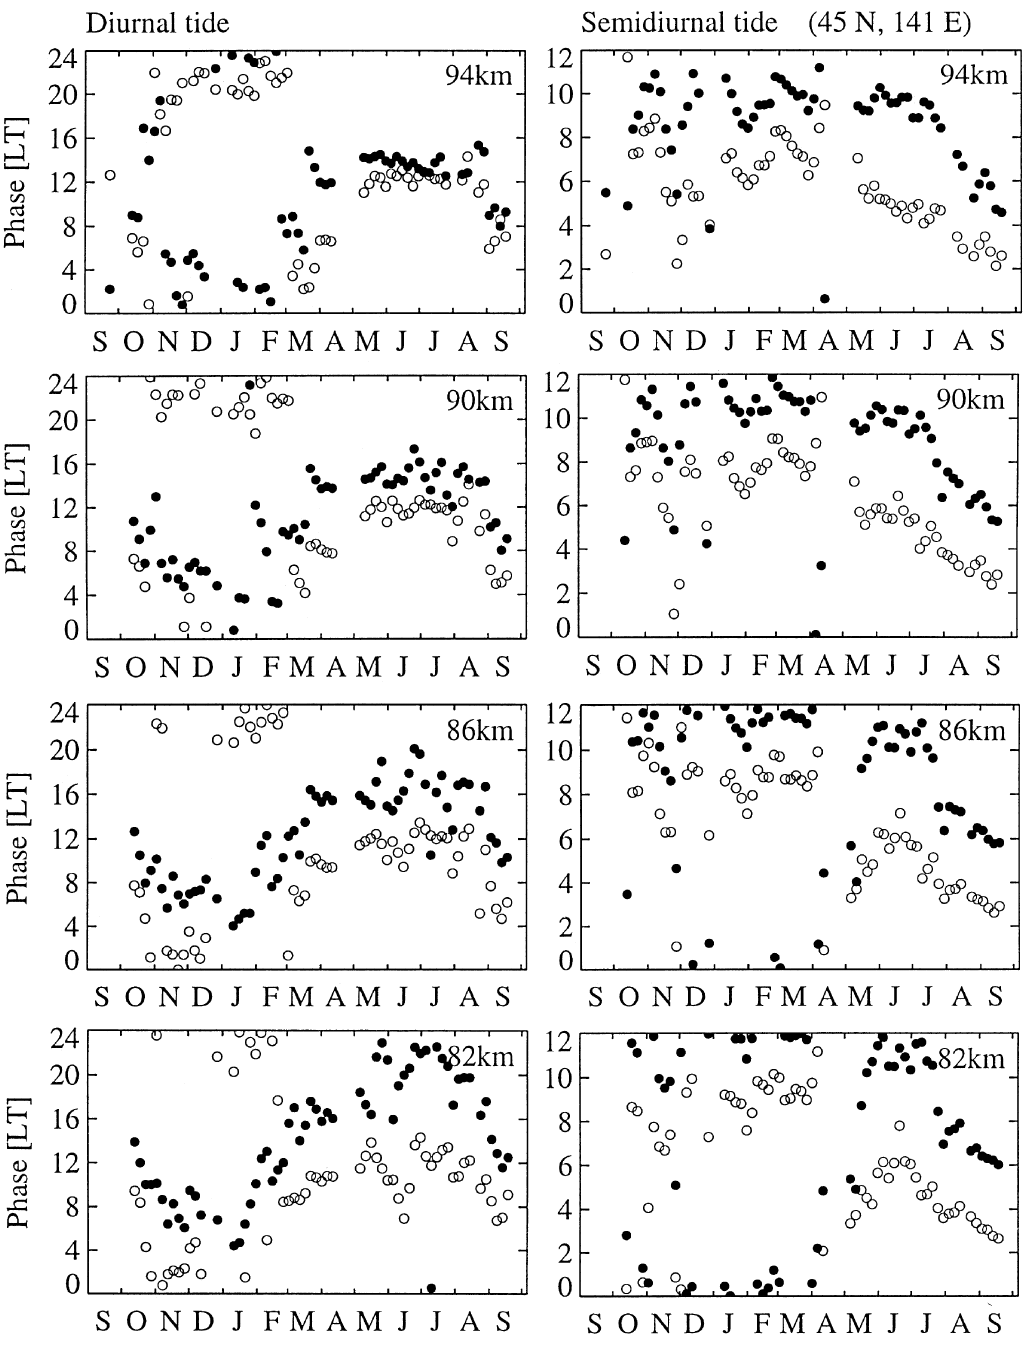
Fig. 4. Same as Fig. 3 but at Wakkanai (45